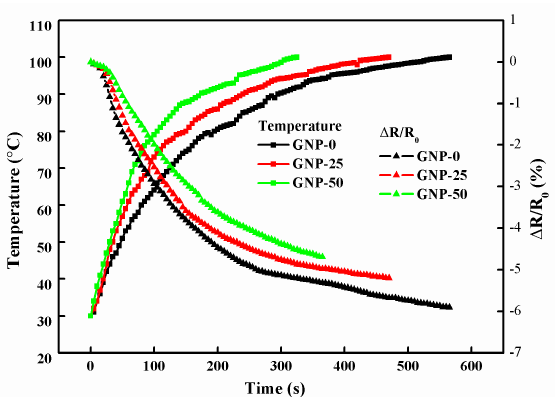
Figure 13. Temperature and resistance responses of the hybrid films placed in an oven at temperature of 100 ◦